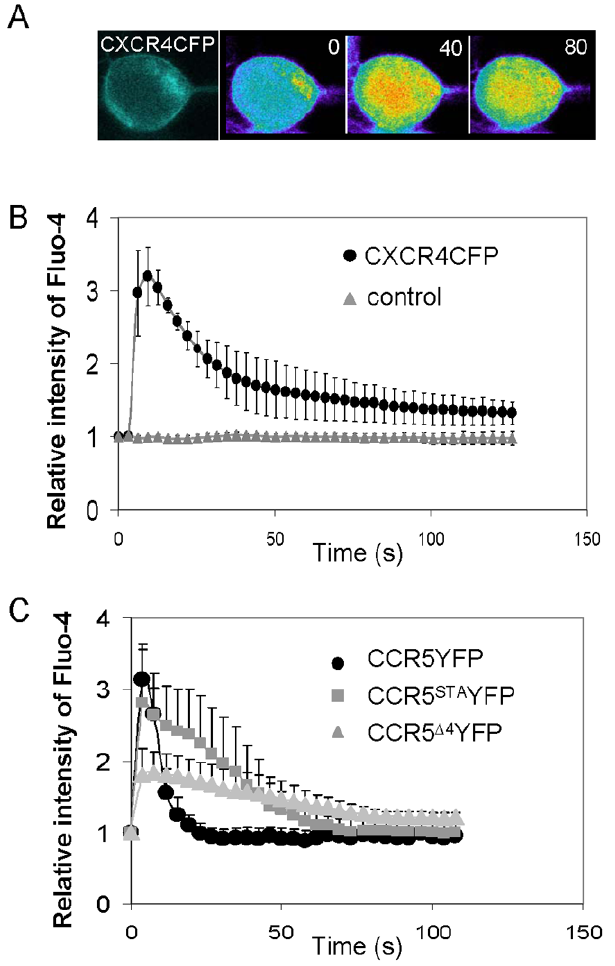
Figure 2. Ligand-induced Ca 2 + response in living cells express- ing CXCR4CFP, CCR5YFP, CCR5 STA YFP or CCR5 D 4 YFP. A. CXCR4CFP mediated a transient intracellular Ca 2 + elevation, which is visualized as intensity changes of Fluo-4 (rainbow color). SDF-1 was added at time 0. B. A time course of intracellular Ca 2 + changes following the addition of SDF-1 at time 0. SDF-1-induced Ca 2 + response